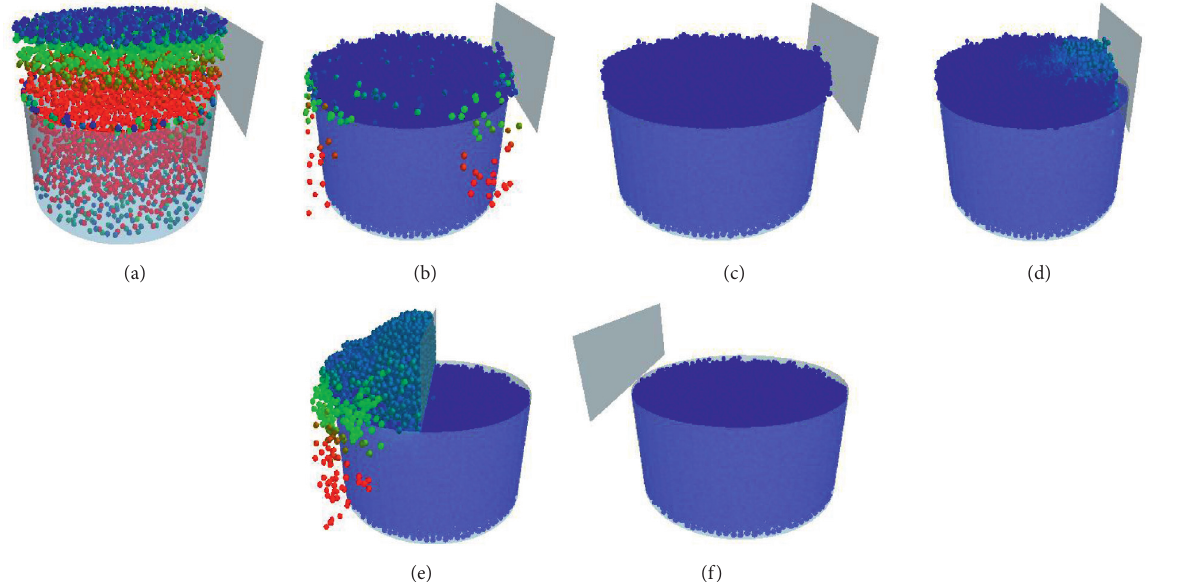
Figure 3: Calibration process of wheat flour simulated grain density. (a) Particles injection start. (b) Particles injection end. (c) Particles stand still. (d) Particles scraping begin. (e) Particles scraping process. (f) Particles scraping